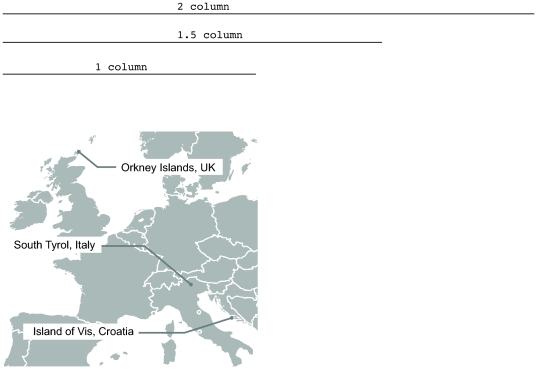
Geographic distribution of study samples.